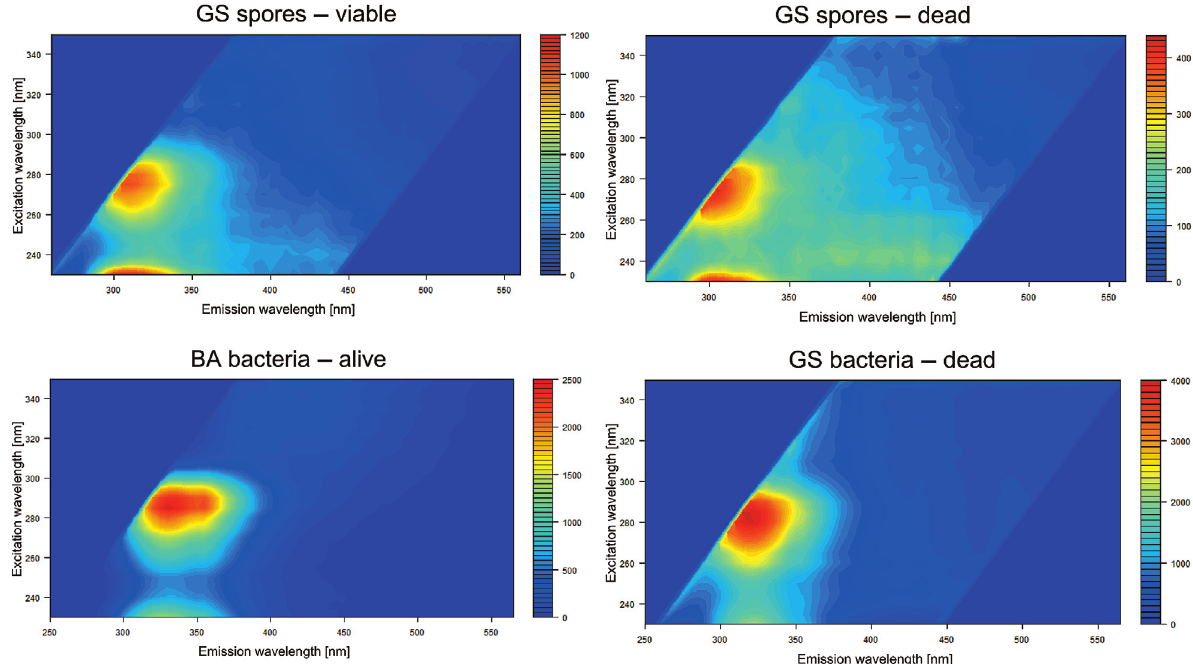
Fig. 3. SFS spectra of viable GS spores (top left), VHP-killed GS spores (top right), living GS bacteria (bottom left) and VHP-killed GS bacteria (bottom right). In SFS spectra, the vertical axis denotes the excitation wavelength, the horizontal axis shows the emission wavelength and the spectral intensity is colour-coded. The spectral maximum shifts towards shorter wavelengths in all decontamination